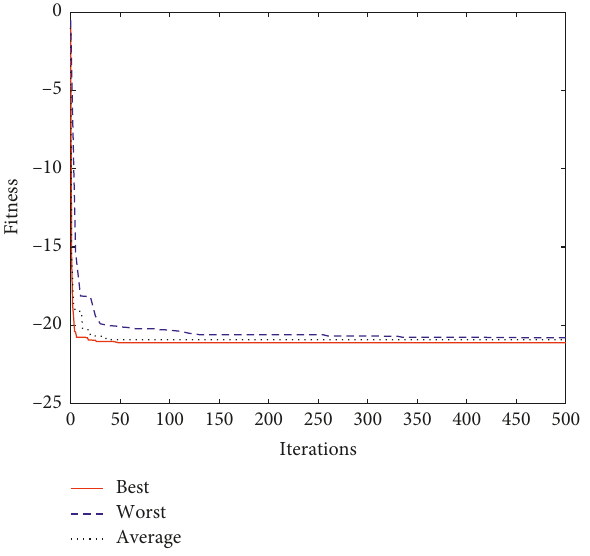
Figure 3: Convergence characteristics of GOA for 10-element linear array in example 1.